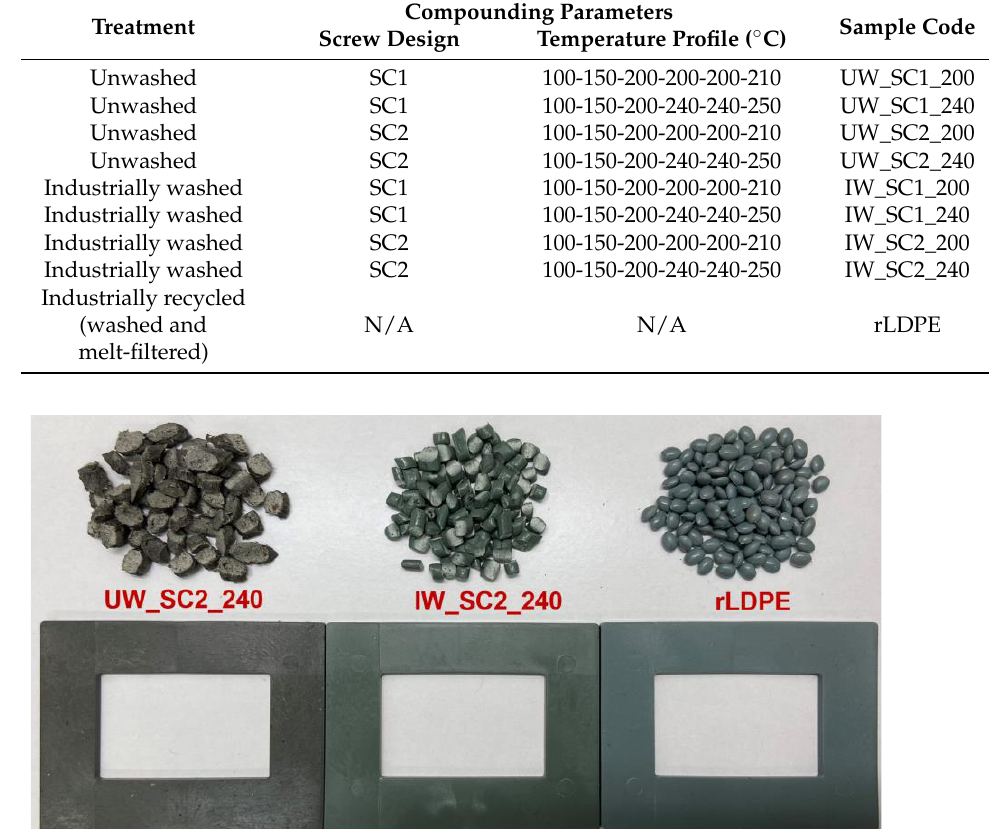
Figure 2. Examples of pellets and injection-molded samples.